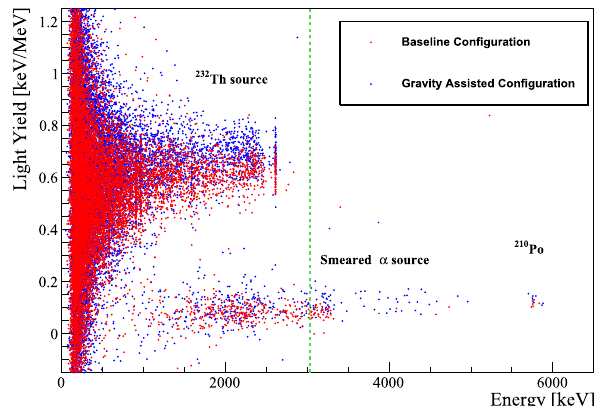
Fig. 5 Light Yield as a function of the energy deposited in the LMO crystal. Red: baseline configuration; blue: gravity-assisted configura- (cid:2) tion. Green vertical line: Q -value of 100 + p 2 × E , here shown p 2 0 1